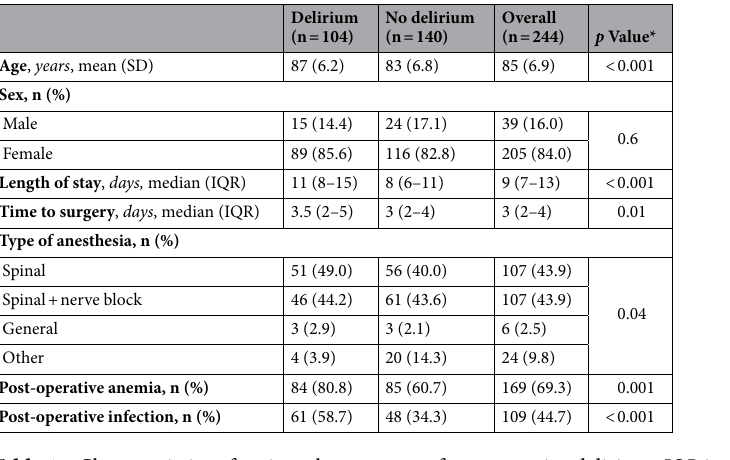
Table 1. Characteristics of patients by presence of pre-operative delirium. IQR interquartile range, SD standard deviation. * p Value for t test (age), Mann–Whitney test (length of stay and time to surgery) or Fisher exact